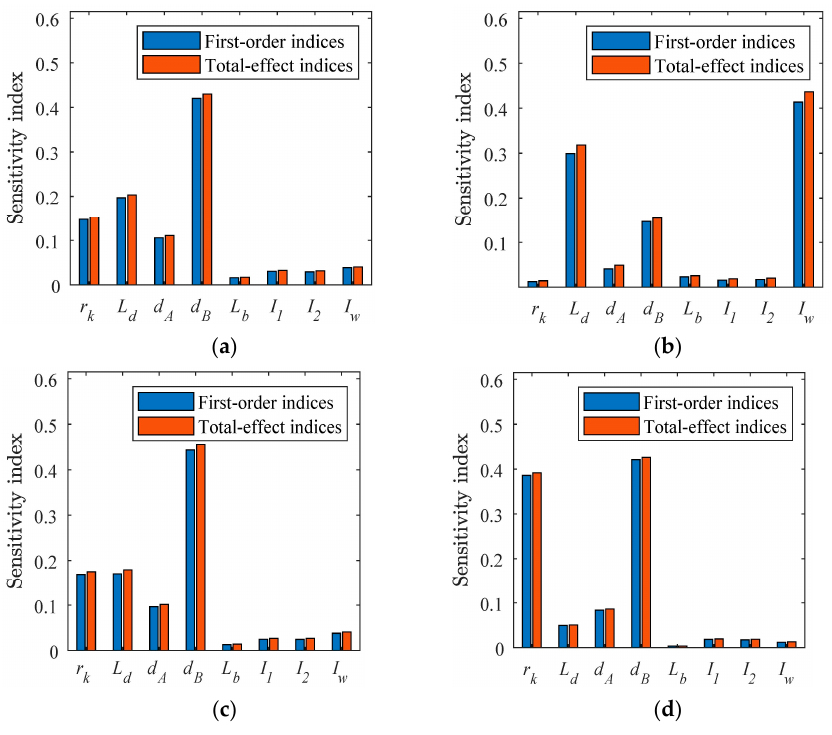
Figure 10. The sensitivity indices for the four landing responses: ( a ) Max load of strut friction; ( b ) Shock-strut efficiency; ( c ) Max overloading of the sprung mass; ( d ) Shock absorber stroke.